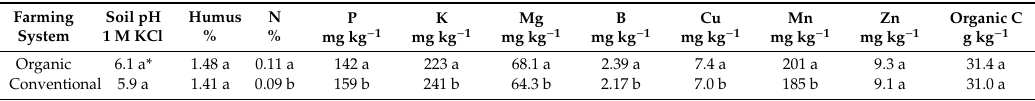
Table 1. Soil characteristics before the establishment of the experiment (2012) in the 0–25 cm soil layer—the soil under the white mustard crop.